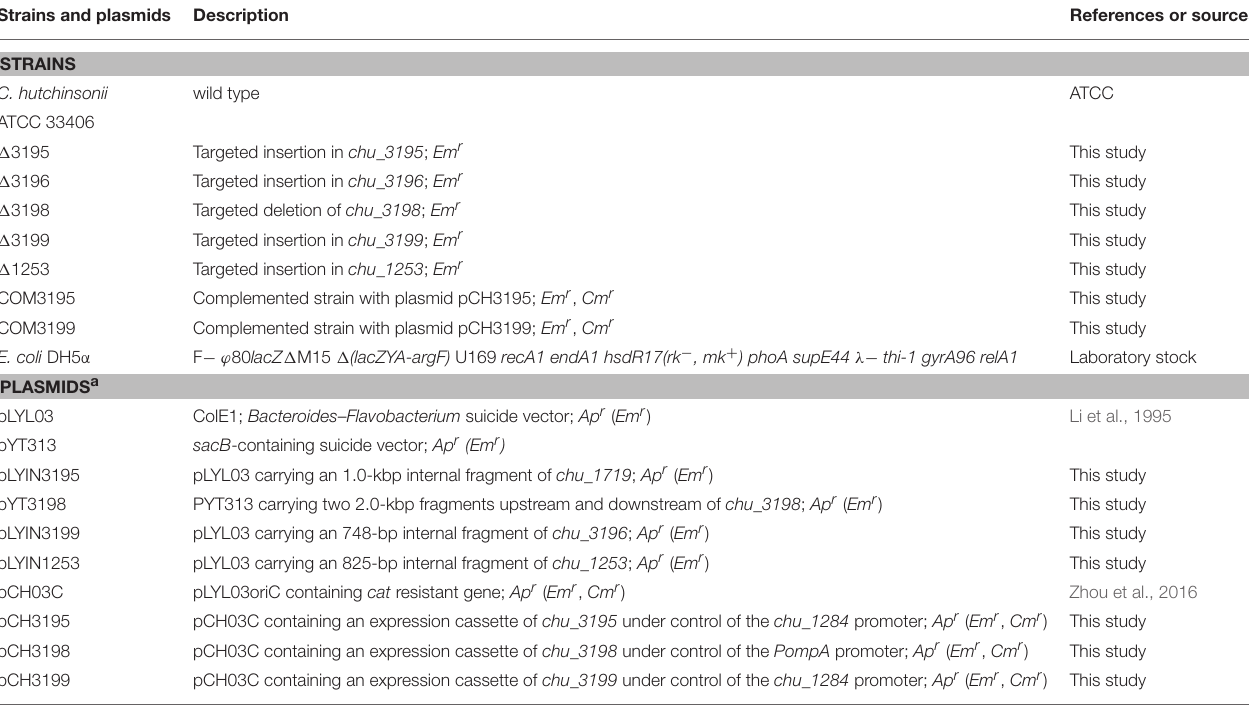
TABLE 1 | Strains and plasmids used in this study. Strains and plasmids